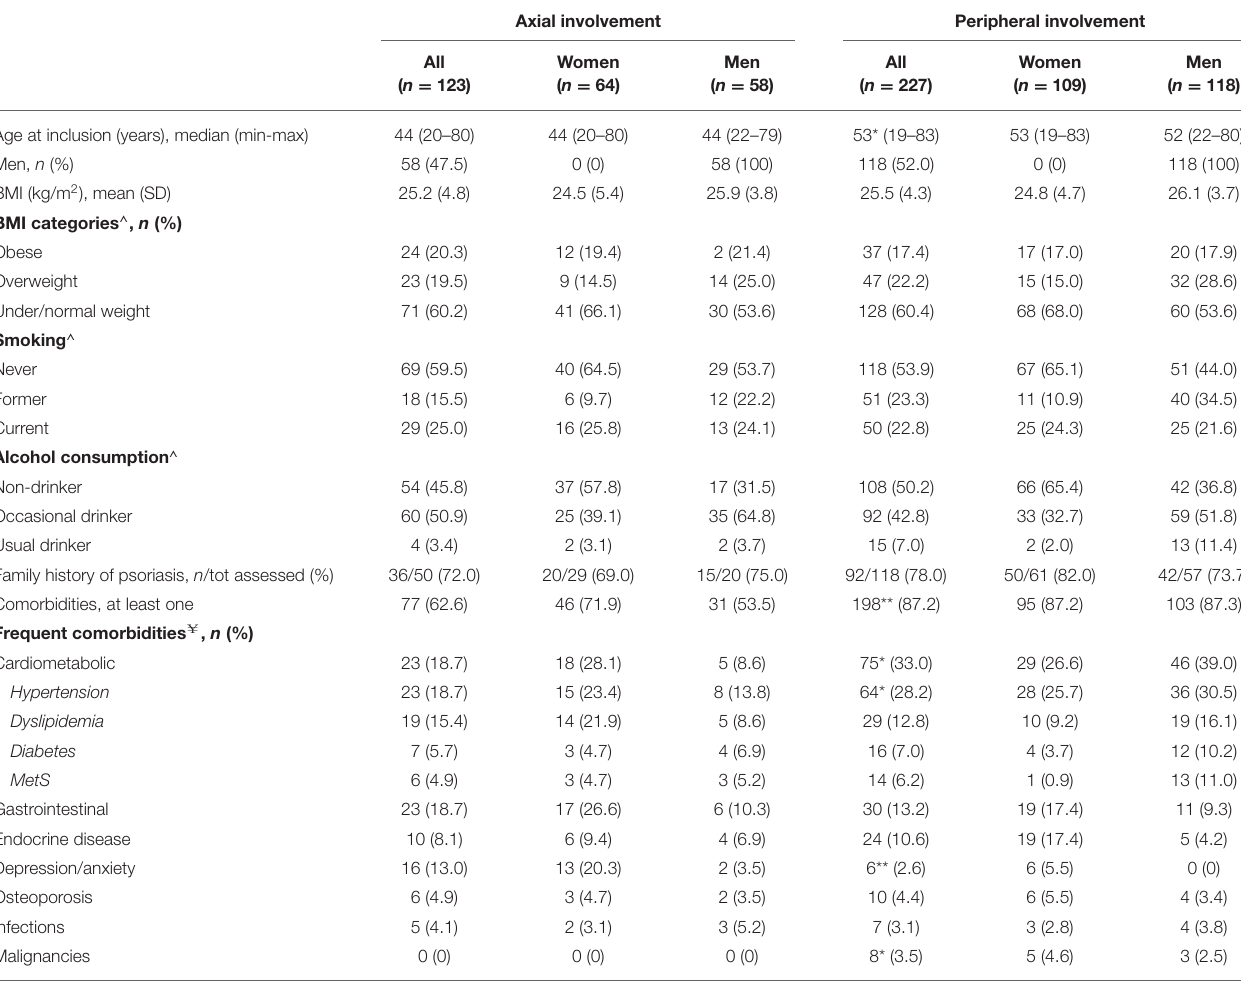
TABLE 1 | Baseline demographic features and comorbidities in 350 patients with SpA in the SIRENA study by involvement pattern and, in each subgroup, by gender ◦